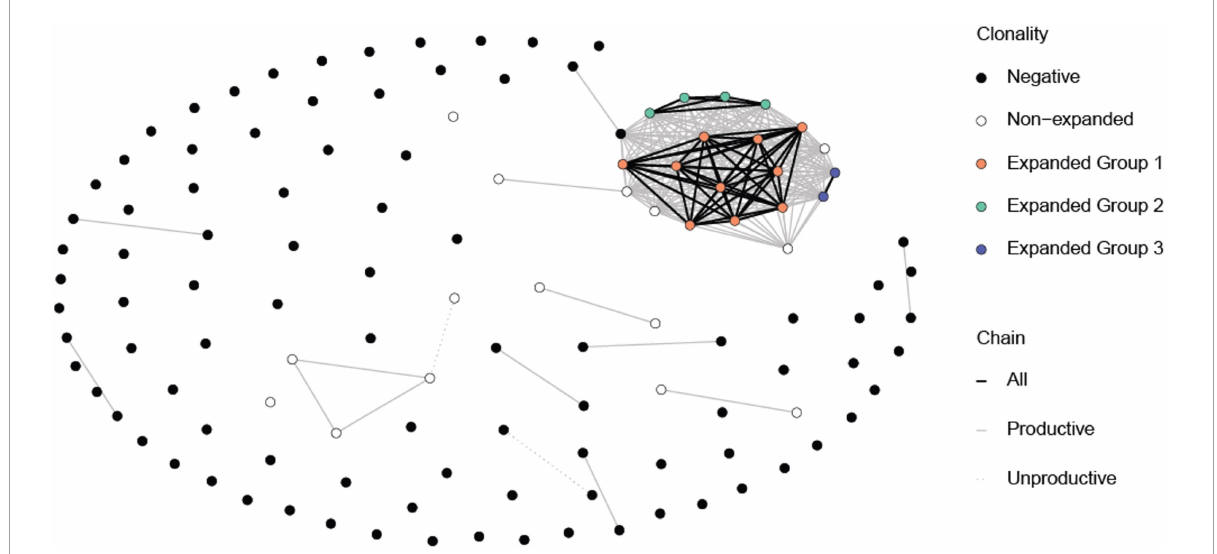
FIGURE1 Common TCR α and β chains among the P6 + and P6 - cells. Each circle represents a cell. The expanded P6 + cells (orange, green and blue circle) have at least one chain in common amongst themselves. A few non-expanded P6 + cells also have some common chains with expanded P6 + cells even though they may not belong to the same clonotype. Expectedly, P6 - cells mostly do not have chains in common. Lines represent at least one common chain between the cells at its termini. Line color represents which chain (s) is shared. Clonotypes were based on having the exact same reconstructed chains for both productive and non-productive chains. Cells with no successful reconstructed chains were not included in this